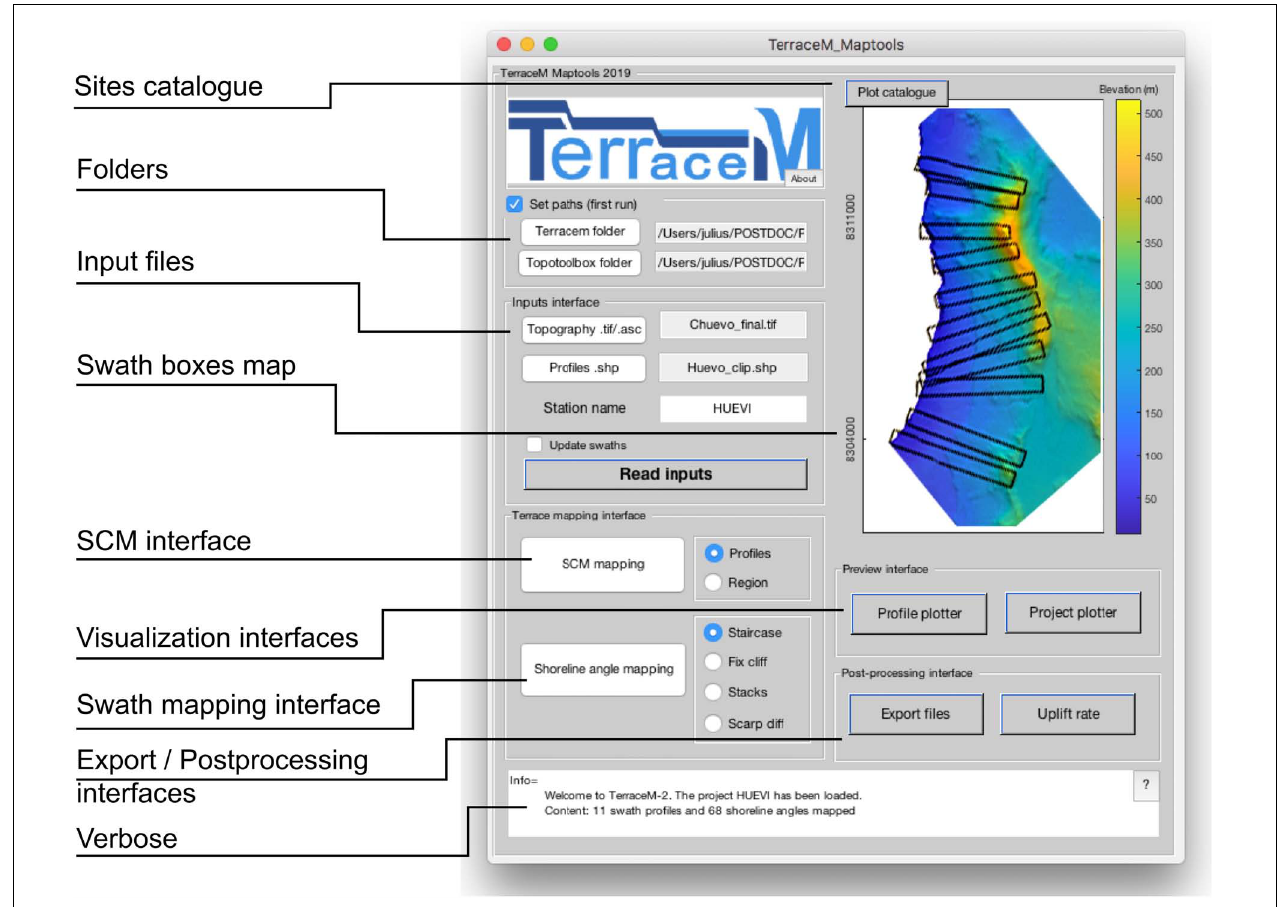
FIGURE 2 | TerraceM Maptools (MAP) GUI (see text for further